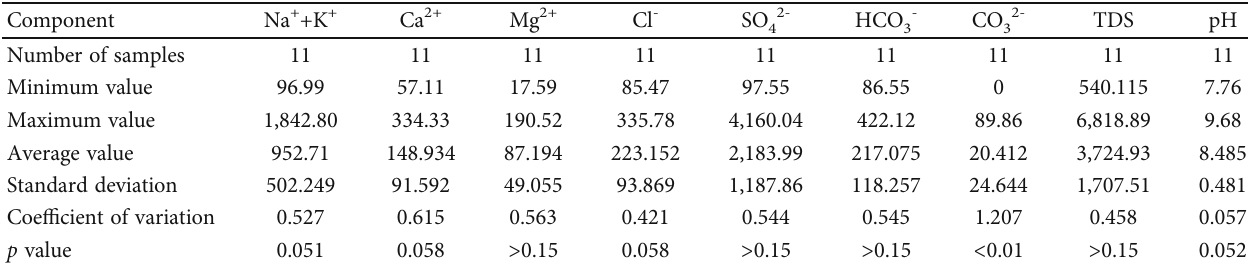
Table 3: Statistical characteristics of loose aquifer content in experimental coal